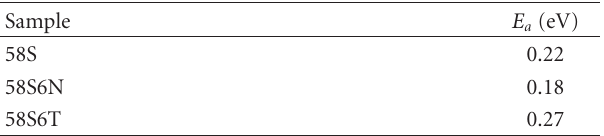
Table 3: Activation energy of Si ions release from di ff erent bioactive glasses in Tris-HCl bu ff er solution. Sample